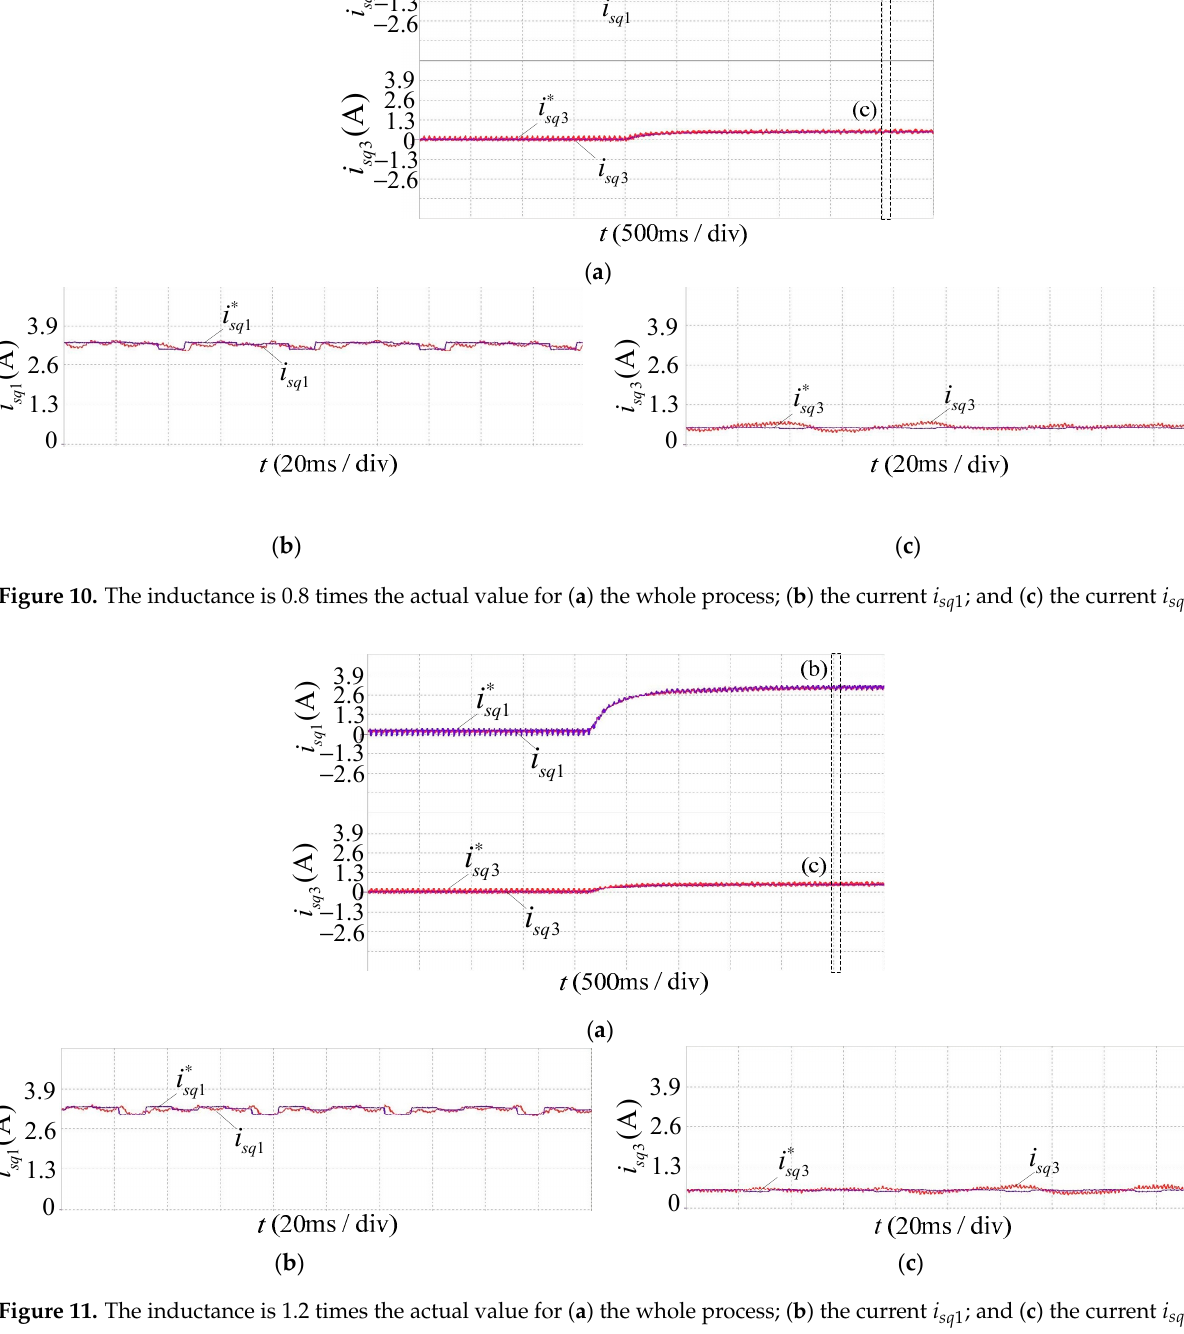
i ; and (c) the current 1 sq